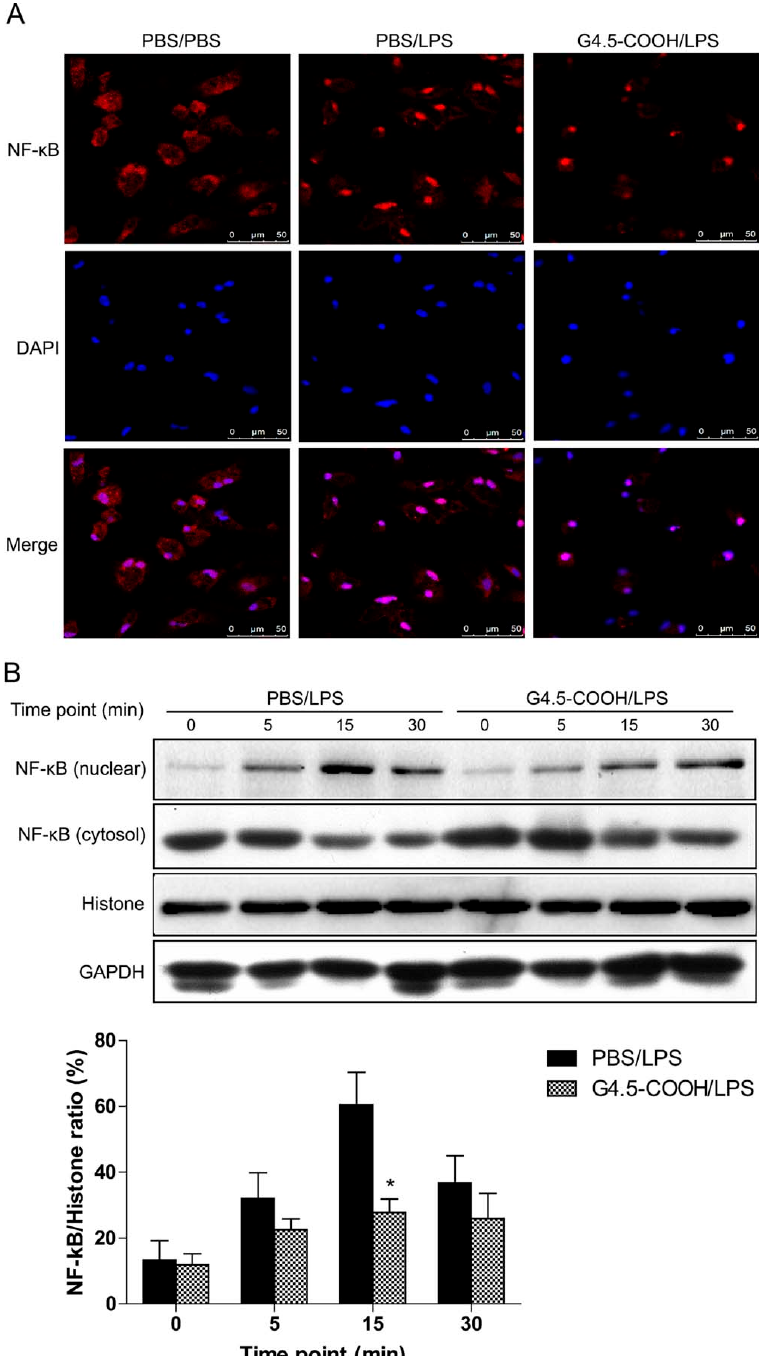
Figure 2. Inhibition of pancreatic inflammatory response by G4.5-COOH is associated with inhibition of NF- κ B nuclear translocation in macrophages. ( A ) Macrophages were preincubated with PBS or G4.5-COOH, followed by lipopolysaccharide (LPS) for 30 min after stimulation of inflammation for confocal assays. Alexa Fluor-labeled NF- κ B protein is shown in red, and DAPI-labeled cell nuclei are shown in blue. After LPS stimulation for 0, 5, 15, and 30 min, cytoplasmic and nuclear proteins were extracted from the macrophages, and the expression of NF- κ B protein. ( B ) The expression of NF- κ B in the cytoplasm and nucleus of macrophages was detected by Western blot and the results were quantified. * p < 0.05, compared with PBS pretreated group. Reprinted (adapted) from [78]. Copyright 2015, with permission from the American Chemical